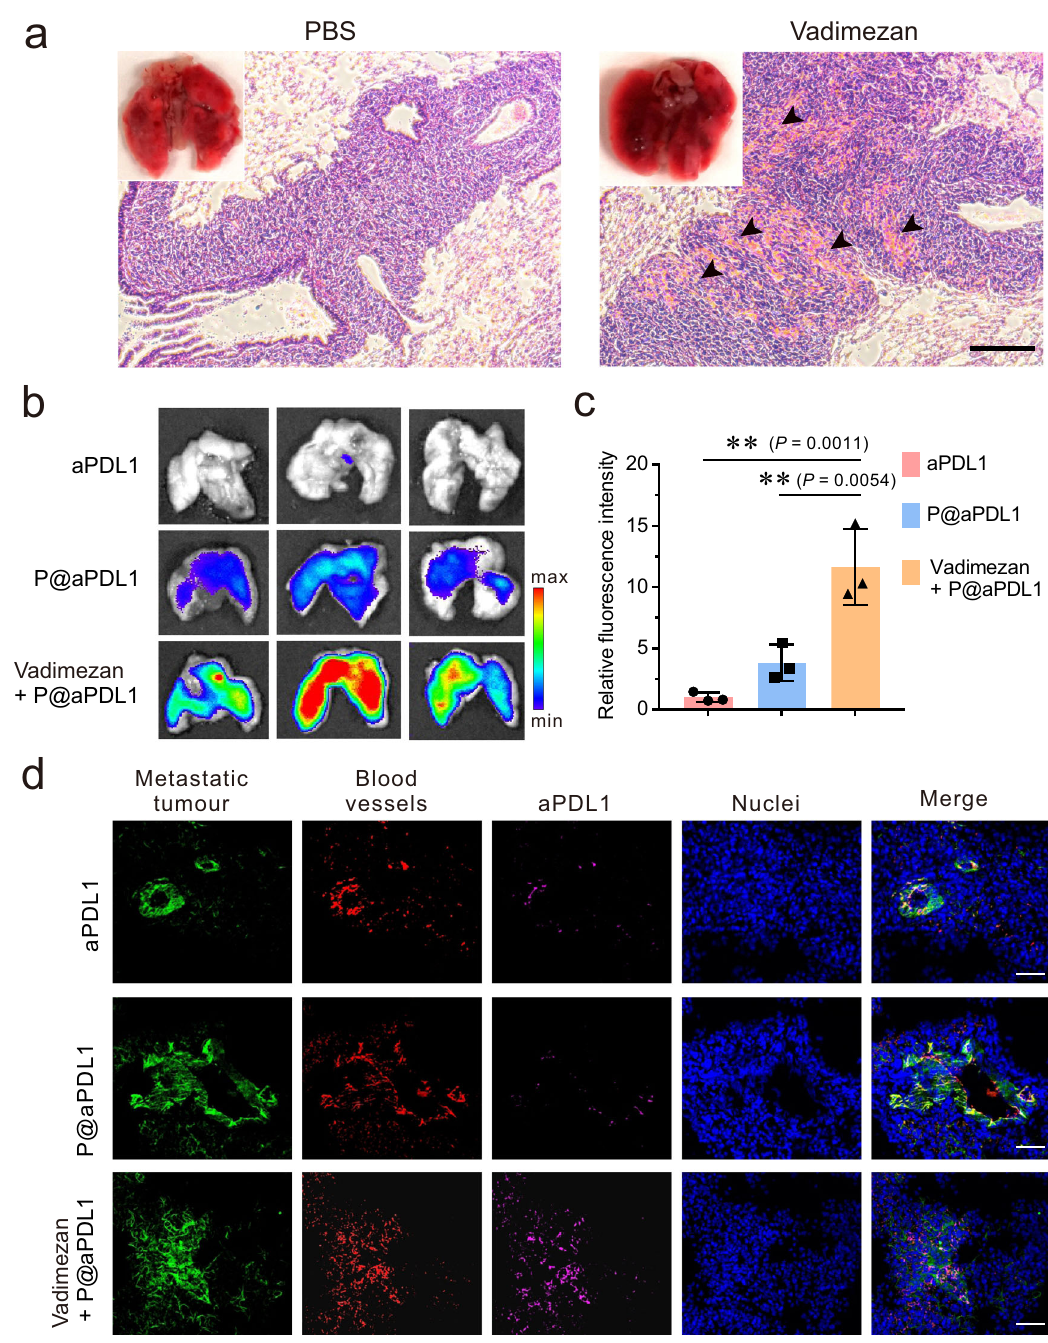
Fig. 2 P@aPDL1 recruitment at the tumour site after Vadimezan treatment. a Photographs and H&E staining images of the 4T1 tumour metastasis in the lung post-treatment with PBS and Vadimezan. Black arrows marked the haemorrhaging sites within the tumour, scale bar: 100 µ m. b Fluorescence images showing the accumulation of aPDL1-Cy5.5 in the tumour metastases within the lung. c Quantitative analysis of the fl uorescence intensity of aPDL1 in the lungs, n = 3 biologically independent animals, data are prestented as mean ± SD. d Confocal images showing the aPDL1 distribution within metastases in the lung. Metastatic tumour cells expressed GFP (green), blood vessels were marked by AF568-anti-CD31 antibody (red), and the aPDL1 was marked by Cy5-conjugated anti-rat IgG antibody (magenta), nuclei were labelled by Hoechst 33342 (blue), scale bar: 50 µ m. Data are presented as mean ± SD, statistical signi fi cance was analysed via ANOVA (one-way, Tukey post-hoc test). P -value: ** P <